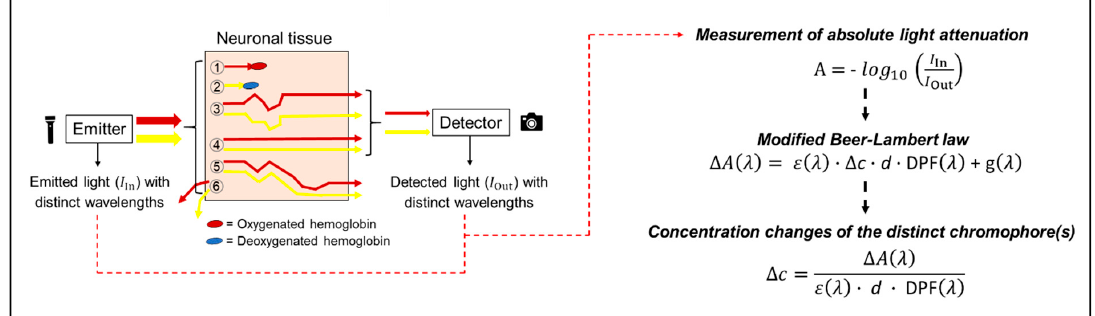
Figure 2. Schematic illustration of light propagation through the neuronal tissue. On the left side of the illustration, possible photon paths for different wavelengths are depicted (red colors represent wavelengths of λ > 800 nm (mainly absorbed by oxyHb—see Photon 1), whereas yellow colors represent wavelengths of λ < 800 nm (mainly absorbed by deoxyHb—see Photon 2). Path 3 represents a photon that undergoes some scattering events before being recorded by a detector. Path 4 represents a ballistic photon. Path 5 represents a photon that, after some scattering events, is not recorded by a detector (lost due to forward scattering). Path 6 represents a photon that is lost due to backward scattering. In the right part of the illustration, the formulas to calculate concentration changes in chromophores are shown (based on continuous wave NIRS). The symbols have the following meanings: A: light attenuation, or ΔΑ ( λ ): changes in light attenuation at a certain wavelength ( λ ); Ι Ι n : intensity of emitted light; Ι Out : intensity of recorded light; ε ( λ ): the extinction coefficient of the chromophore at a certain wavelength ( λ ); Δ c: changes in chromophore concentration; d: separation (distance) between source and detector; DPF( λ ): differential path length factor (DPF) for a certain wavelength ( λ ); g( λ ): scattering at a certain wavelength ( λ ), where g is cancelled out since it is assumed to be negligible when only light attenuation (as in continuous wave NIRS) is considered [45,54,58].